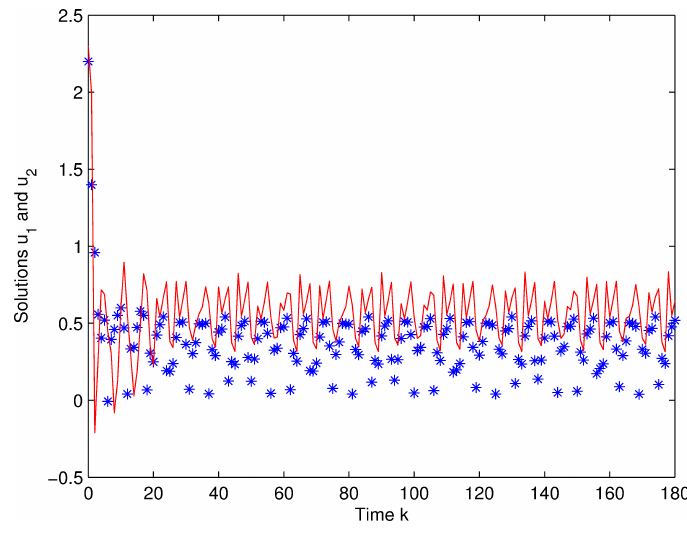
Fig. 4. Times series of u 1 and u 2 for system (74) , where the blue line stands for u 1 and the red line stands for u 2